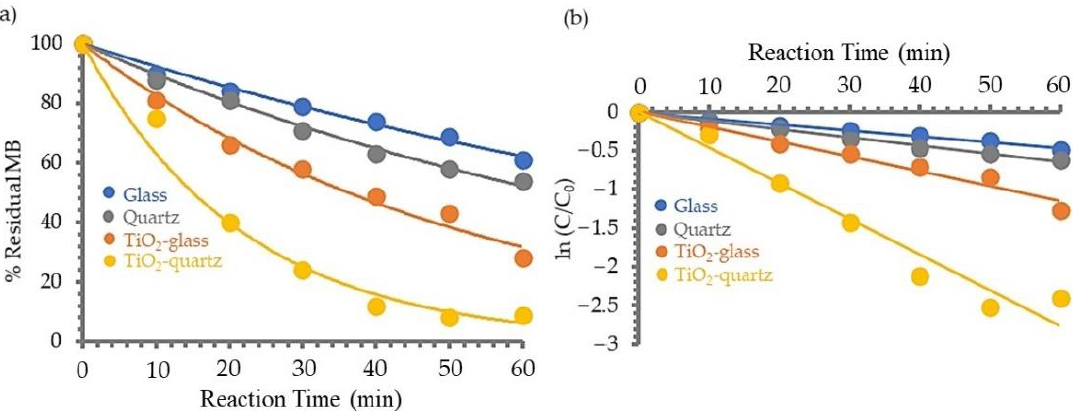
Figure 3. Photosensitivity of TiO 2 film on MB in the absence and presence of TiO 2 film coated on glass and quartz substrates: ( a ) photodecomposition of MB, and ( b ) photodecomposition kinetics of MB.